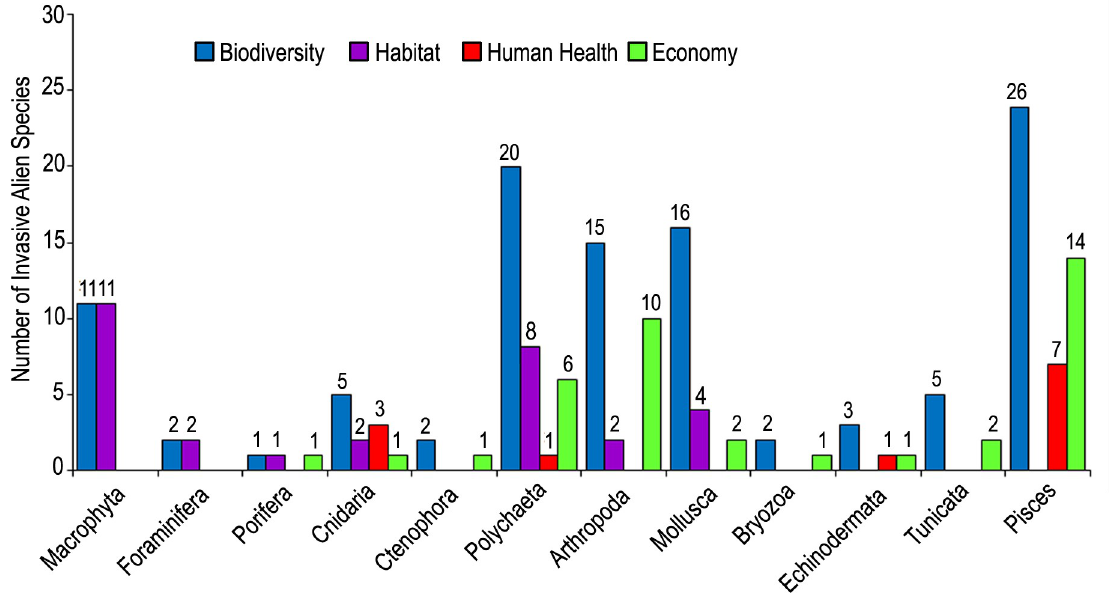
Fig 15. The number of invasive alien species affecting to native biodiversity, habitats, human health and economy (positive or negative).